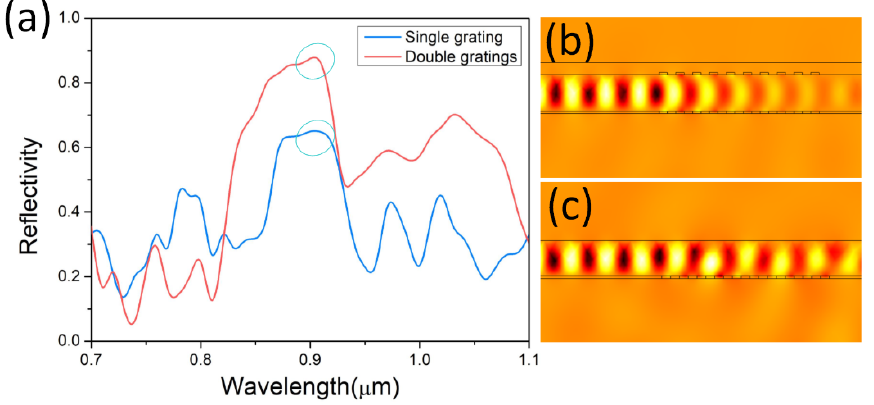
Figure 3. Reflective properties of single grating and double gratings. ( a ) Reflectivity spectra of the nanowire with single grating (blue) and double gratings (red). Profiles of H z of the propagating mode for the nanowire sandwiched in double gratings ( b ) and placed on single grating ( c ). Insets are modal profiles of HE 11a for the nanowire sandwiched in double gratings and in air, respectively.